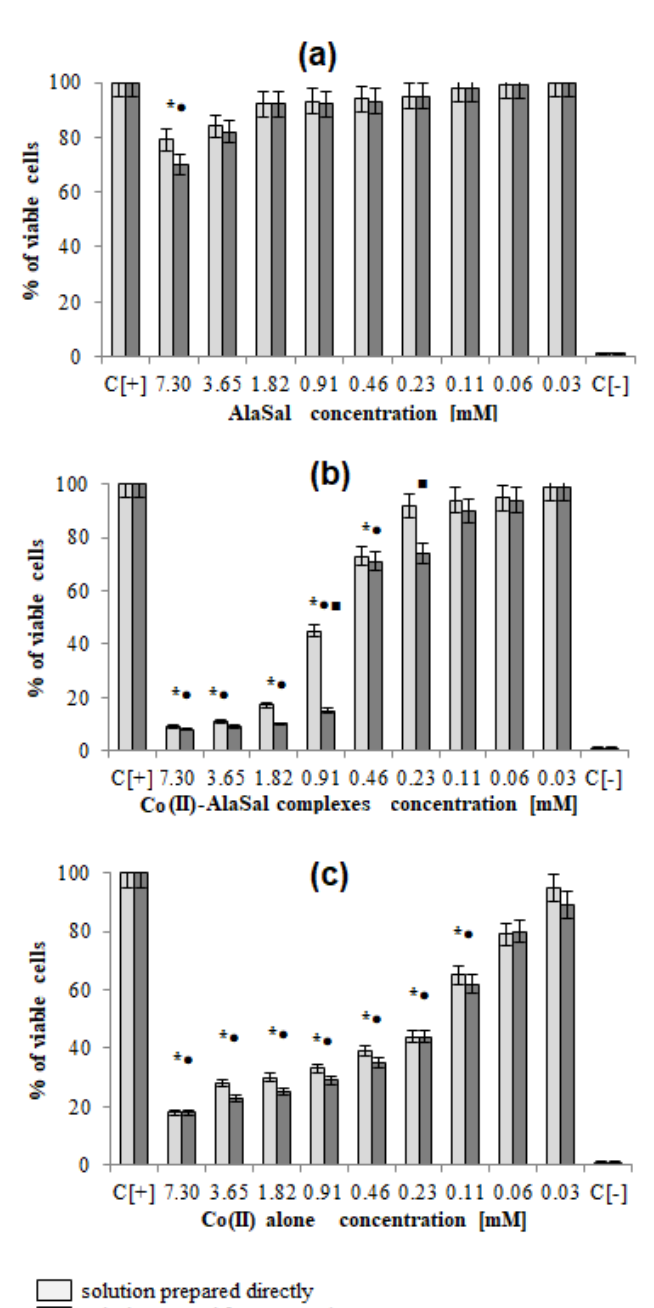
Figure 5. Cytotoxic effect of investigated compounds: ( a ) AlaSal, ( b ) Co(II)–AlaSal complexes ( c ) Co(II) alone towards L929 cells. The cytotoxicity was assessed by MTT [3-(4,5-dimethylthiazol-2-yl)- 2,5-diphenyltetrazolium bromide)] reduction assay. The cell viability was calculated for four experiments including three repeats for each compound. Complete RMPI-1640 medium (cRPMI) was used as a positive control (C+) of cell viability (100% viable cells) and 0.03% H 2 O 2 as a negative control (C − ) of cell viability (100% dead inactive cells). Statistical significance: *• ■ p < 0.05; * untreated cells vs. cells treated with tested solution (solution prepared directly); • untreated cells vs. cells treated with tested solution (solution stored for two weeks) ■ solution prepared directly vs. solution stored for two weeks.